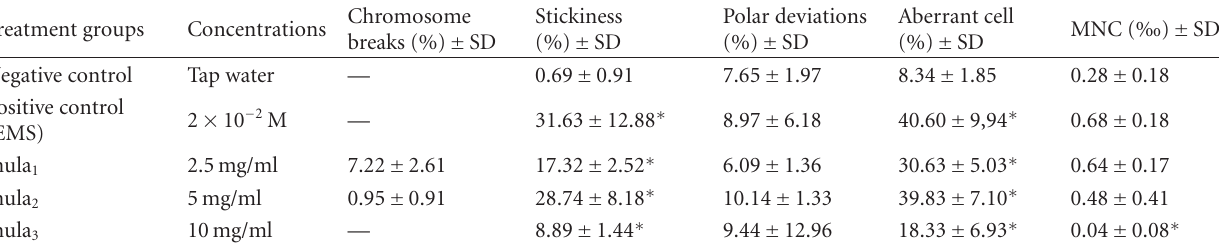
Table 3: Chromosome and mitotic aberrations in the root meristem cells of Allium cepa after I. viscosa leaf extract treatment. Treatment